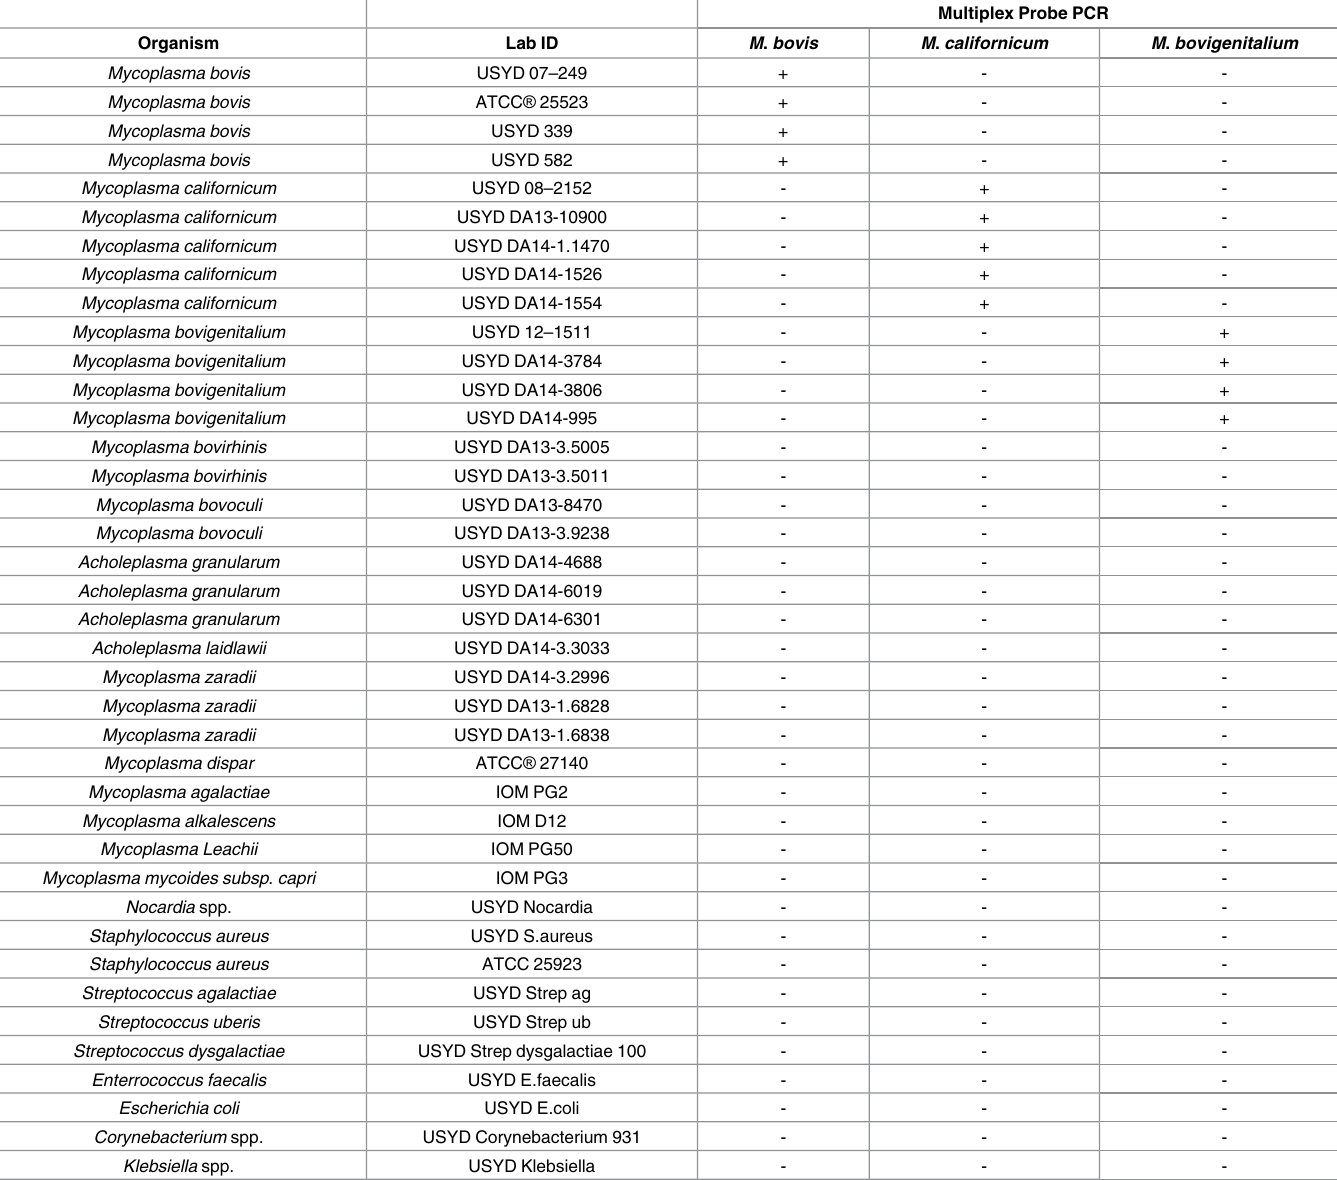
Table 2. Mollicute and other bacterial species used for testing analytical specificity of the multiplex probe PCR